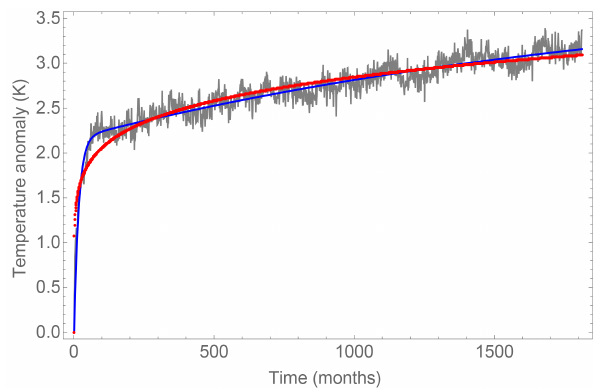
Figure 5. Grey curve is the global temperature response to a sudden quadrupling of atmospheric CO 2 concentration in the GISS E2-R model. Blue curve is a fit of superposition of two exponential re- sponses (two-box model solutions), with the two exponential time constants being τ 1 = 1 . 3 years and τ 2 = 176 years. Red curve is a power-law fit and is a poor fit up to several